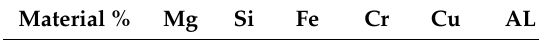
Table 1. Chemical composition of AA 6061 material.